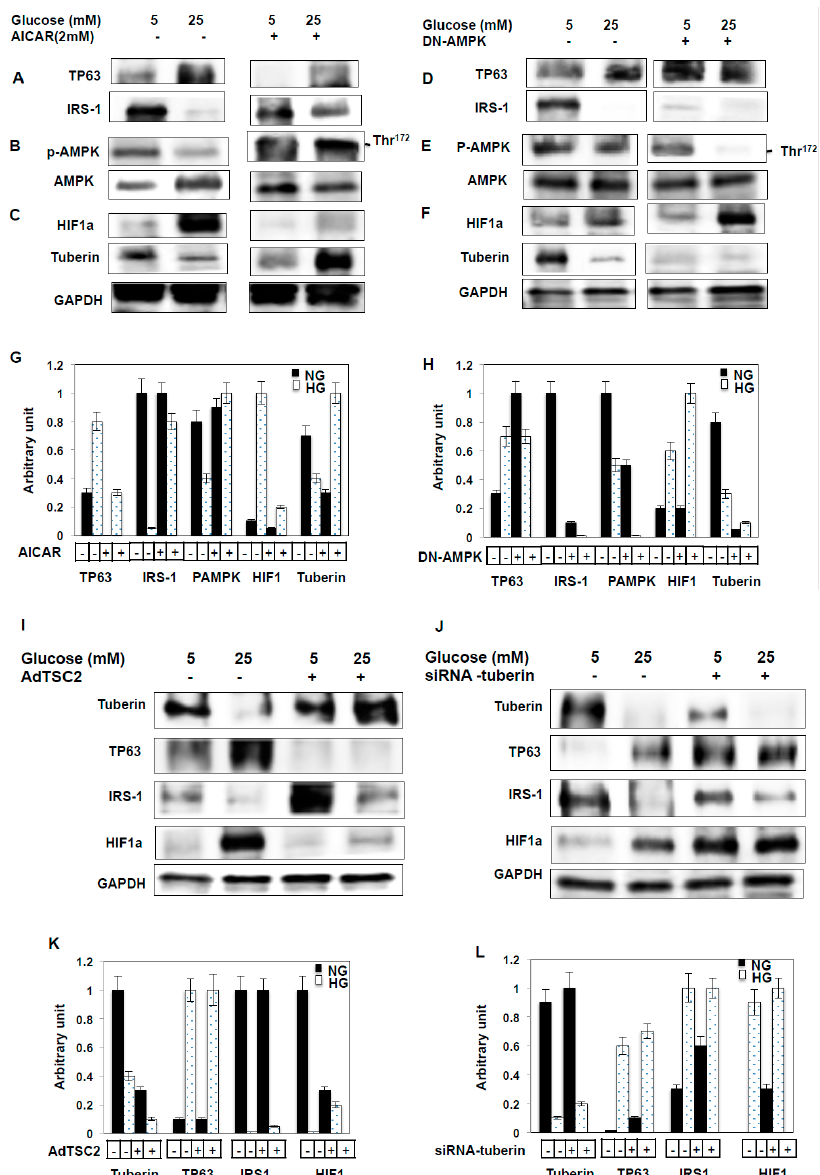
Figure 4. Activation of AMPK by AICAR decreases TP63 and increases IRS-1, and over-expression of tuberin resulted in decreased TP63 expression. MCT cells were treated with AICAR (2mM) or transfected with DN-AMPK. ( A ) AICAR treatment abolished TP63 expression significantly in NG and HG, while IRS-1 expression was decreased in NG and increased in HG. ( B ) AICAR treatment increased the expression of both p-AMPK and AMPK significantly. ( C ) AICAR treatment downregulated HIF1a expression in NG, and the expression of tuberin was downregulated significantly in both NG and HG. ( D ) DN-AMPK transfection significantly downregulated TP63 expression and increased IRS-1 expression. ( E ) DN-AMPK treatment downregulated expression of p-AMPK. ( F ) DN-AMPK transfection increased the expression of HIF1a greatly and significantly downregulated the expression of tuberin under both NG and HG conditions. ( G , H ) Histogram of the average expression of each protein presented as an arbitrary unit was calculated from each protein and normalized by GAPDH from 2 Western blots. ( I , J ) The overexpression of tuberin resulted in significant decreases in TP63 and greatly increased IRS-1 expression compared to non-infected cells under NG and HG conditions. In contrast, HIF1a is significantly downregulated with the overexpression of tuberin and increased with the siRNA-tuberin treated cells compared to non-infected cells under NG and HG conditions. ( K , L ) The average expression of each protein presented as an arbitrary unit was calculated from each protein and normalized by GAPDH from 2 Western